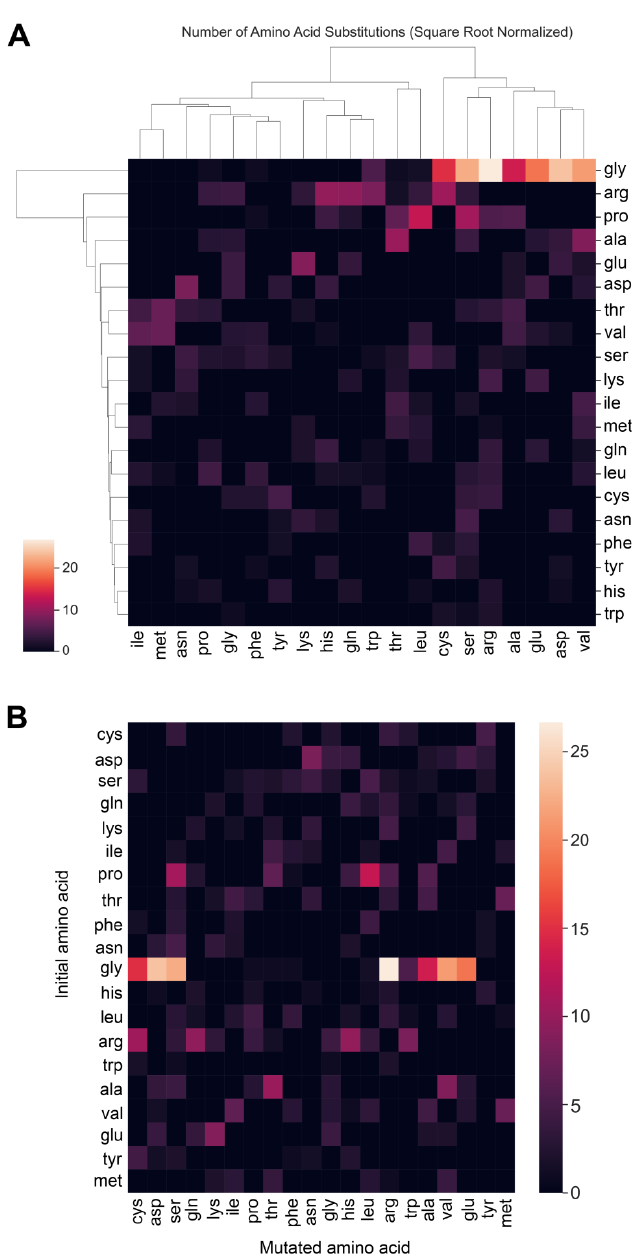
Figure 8. Predominant Mutations in the Collagen Helix. Heatmaps display the ( A ) frequency of amino-acid substitution, where glycine is the most substituted amino acid, and ( B ) the most frequent mutation substitution of glycine for arginine. Highest values indicate predominant amino-acid mutation (Supplementary Table